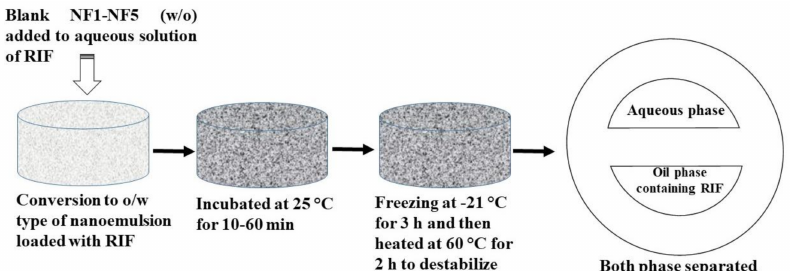
Figure 8. A schematic illustration of a proposed mechanistic perspective for removal of insoluble rifampicin from an aqueous bulk solution using a green nanoemulsion. After dropping of nanoemul- sion to the aqueous drug solution under stirring, there is a probable chance of drug adsorption onto the oil (CMC8) globule surface during incubation at 25 ◦ C. Freeze–thaw ( − 21 ◦ C and subsequent heating at a high temperature (60 ◦ C) resulted in two phase separation (destabilization). The oil phase, with adsorbed (loaded with RIF), was separated by centrifugation for quantitative